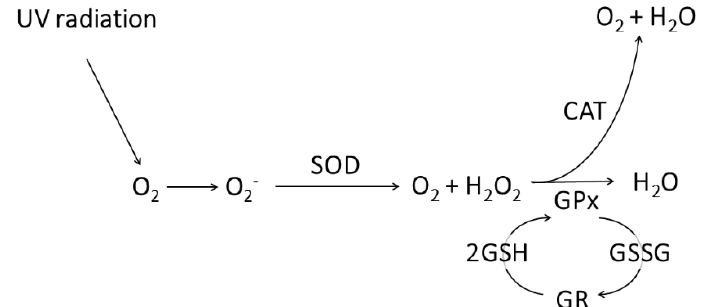
Figure 4. Proposed antioxidant defense mechanism of strain I1P. SOD: superoxide dismutase; CAT: catalase; GPx: glutathione peroxidase; GR: glutathione reductase; GSH: reduced glutathione; GSSG: glutathione disulfide.